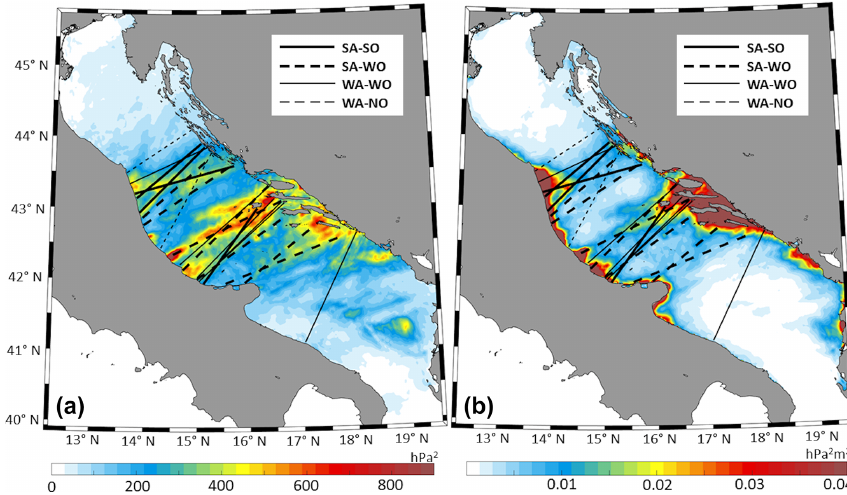
Figure 12. Averaged air pressure variances (a) and averaged new transect sampling criterion (b) estimated for the ensemble of transects extracted between 11 and 19 May 2020. The modelled disturbances (black lines) are categorized depending on the strength of the atmospheric signal (SA for strong and WA for weak) and the ocean response (SO for strong, WO for weak, NO for none).